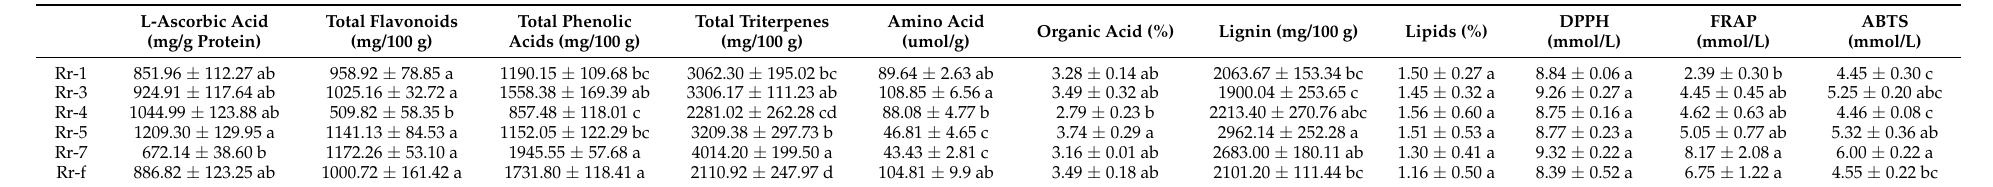
Table 2. The L-ascorbic acid, total flavonoids, total phenolic acids, triterpenoids, amino acid, organic acid, lignin, lipids content, and the DPPH, ABTS, FRAP in all the samples. (Lowercase letters in the table indicate significance, and different letters indicate significant differences among the groups). L-Ascorbic Acid (mg/g